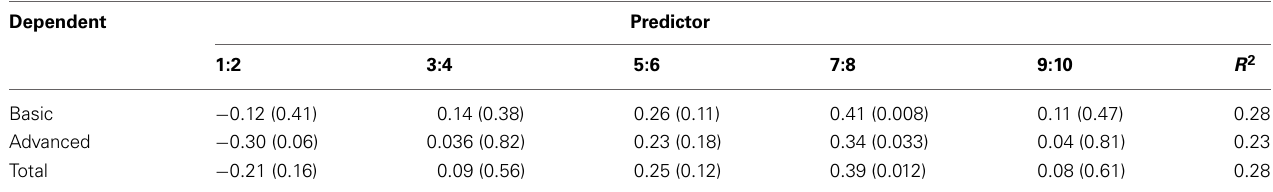
Table 5 | Multiple regression models [(beta-weights ( p -value)], with arithmetic fluency as dependent variable and discrimination performance ( P ) at the different stimulus ratios (difficulties) as